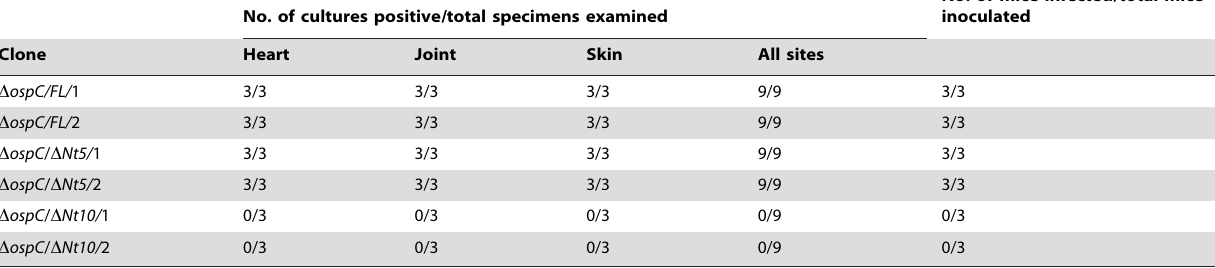
Table 3. The 10-AA deletion abolishes infectivity of B. burgdorferi a